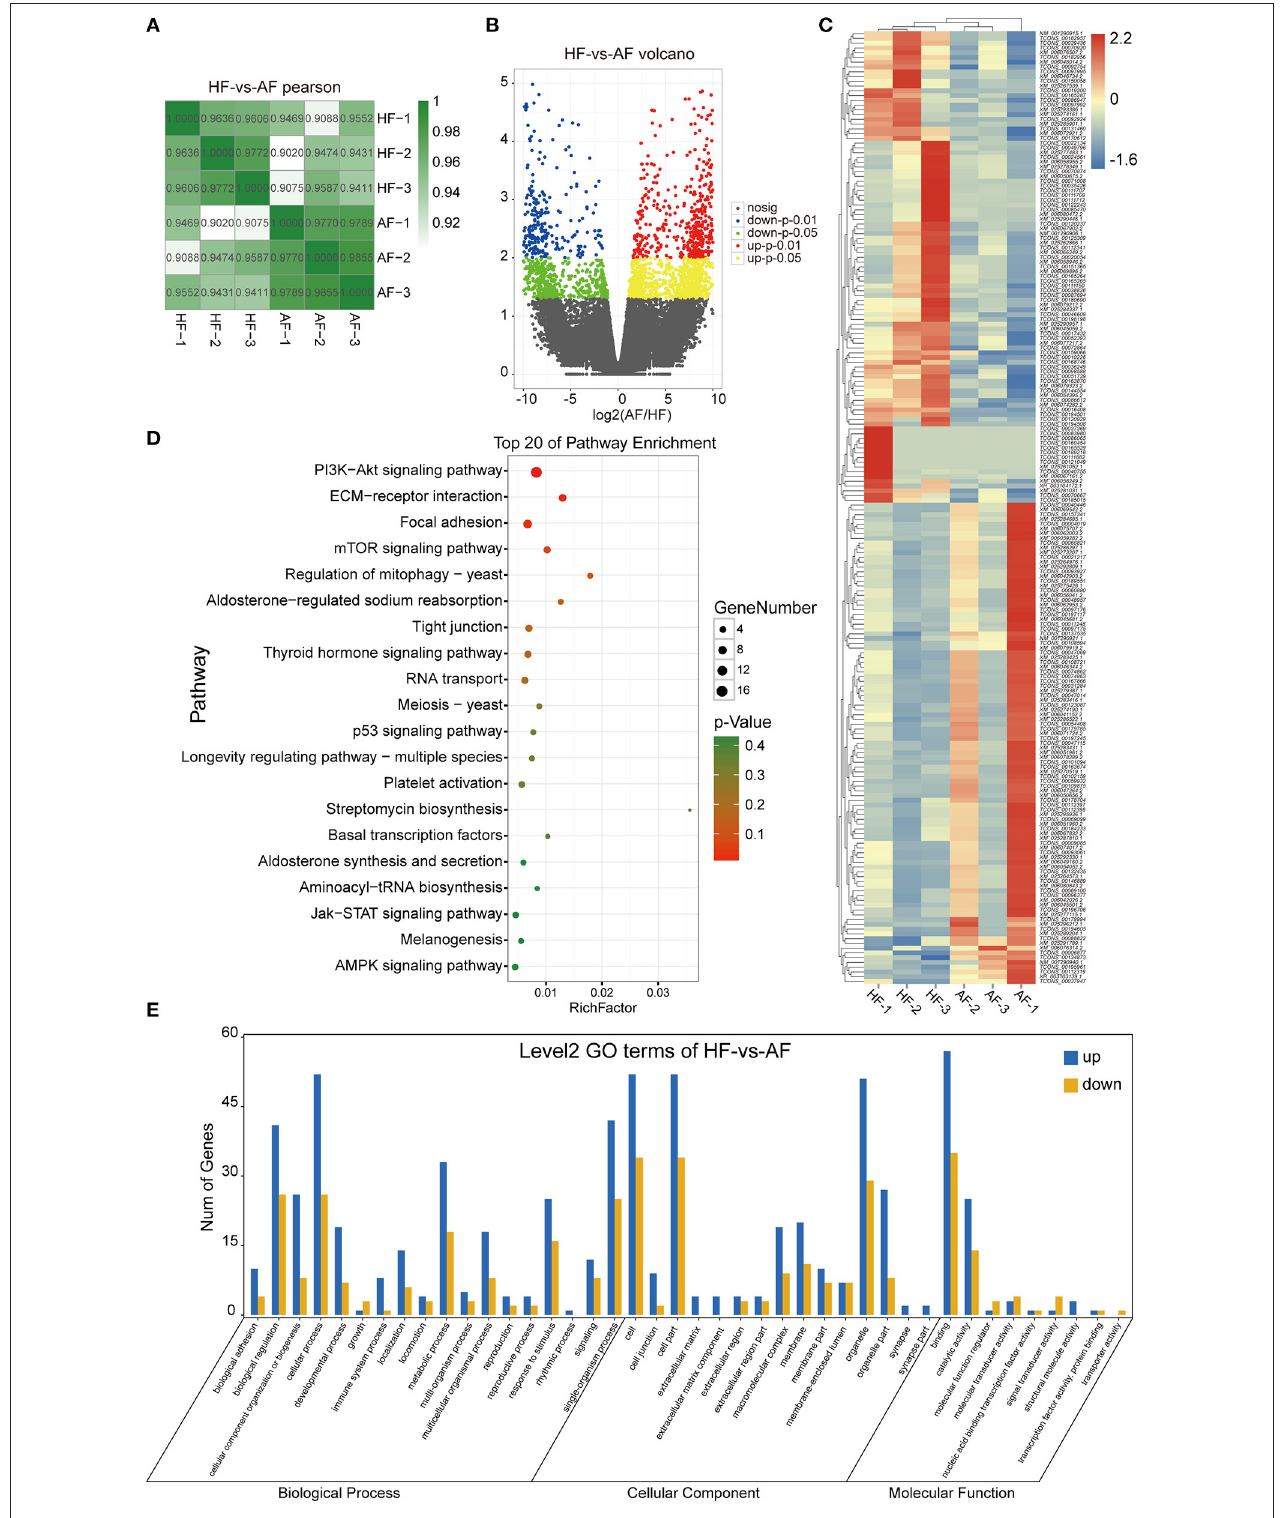
FIGURE 2 | Identification and analysis of DEmRNAs in granulosa cells between healthy and atretic follicles. (A) The Pearson correlation heat map between each sample. (B) Volcano plot diagrams showing log2FC and p-values of DEmRNAs. (C) Clustering heat map for DEmRNAs in each sample between the two groups.